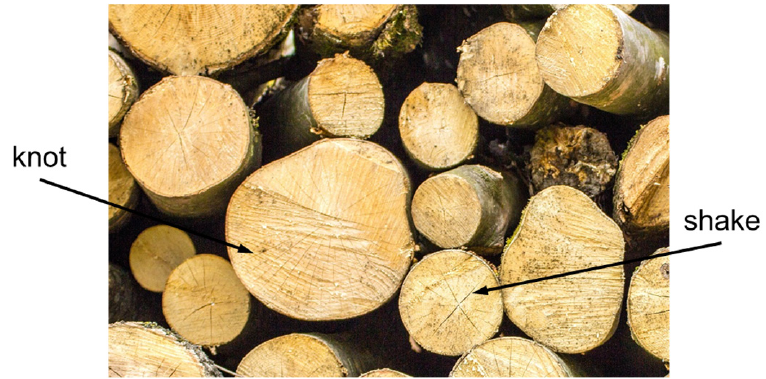
Figure 2. Cross ‐ sections in wood that indicate two common